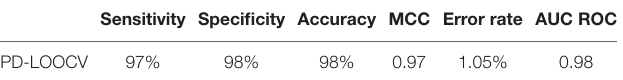
TABLE 3 | Sensitivity, specificity, accuracy, Matthews correlation coefficient (MCC), error rate for the cross validation and area under the curve for the receiving operators characteristic (AUC ROC) curve for the single spectrum Parkinson’s disease leave-one-out cross-validation (PD-LOOCV) classification